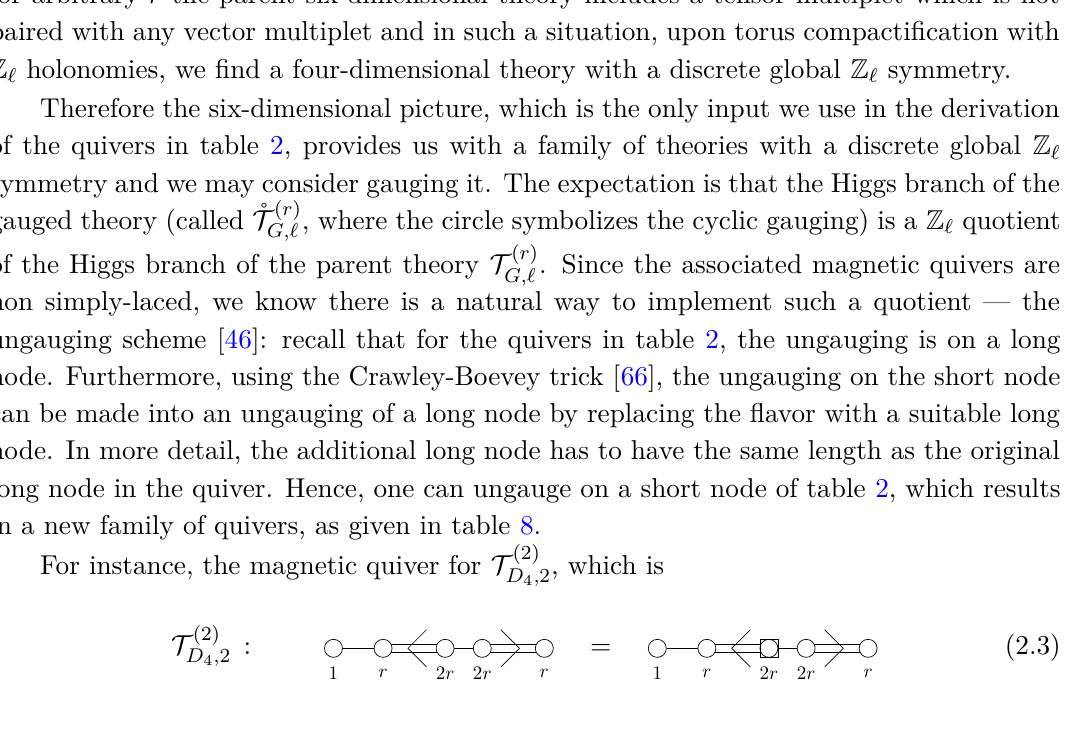
denotes the G -character of a representation with G